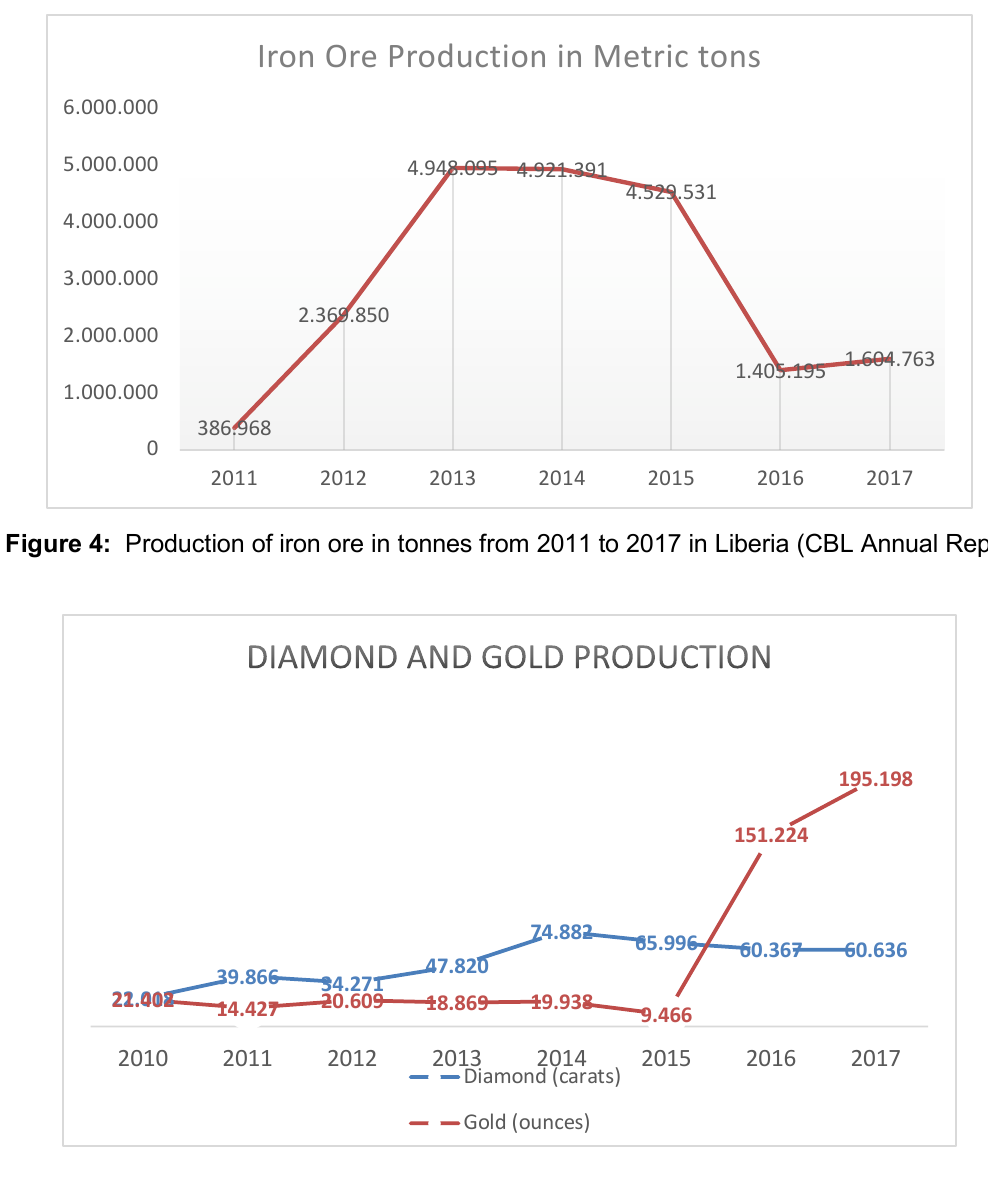
Figure 5: Production of gold and diamond from 2010 to 2017 in Liberia (CBL Annual Reports, 2010-2017)